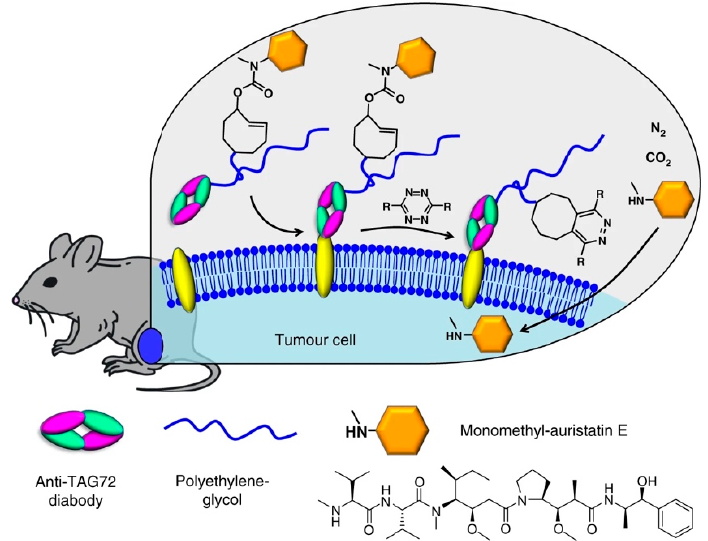
Figure 7. Triggered drug release using “click-to-release” chemistry in vivo: on-tumor liberation of a cell permeable drug (monomethyl auristatin E, MMAE) from a trans -cyclooctene-linked ADC following systemic administration of a tetrazine activator [104].